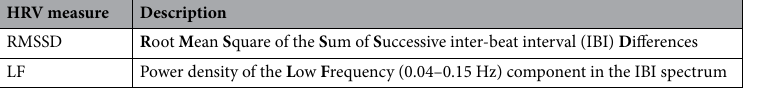
Table 2. Heart rate variability